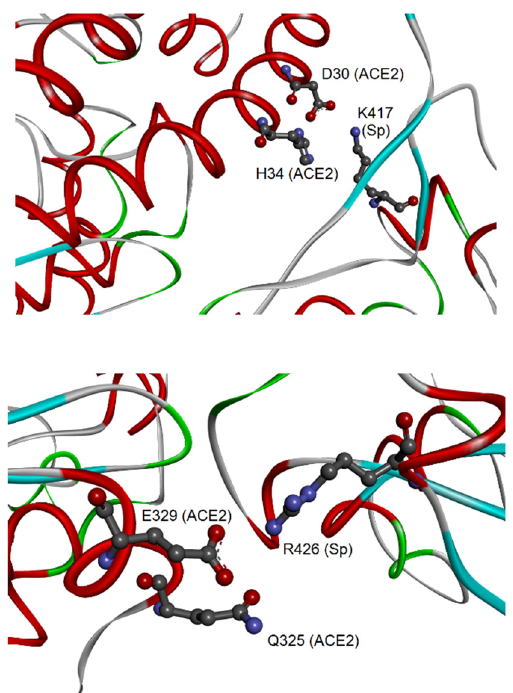
Figure 3. Molecular view of the peculiar interactions formed by CoV-2 K417 and CoV-1 R426 residues of the spike (adapted from Giordano et al., 2021 [37]). The upper panel shows the interaction of CoV-2 spike–K417 with ACE2-D30 and H34; both proteins are represented as backbone ribbons, with helix regions in red, beta-strand regions in cyan, and turns in green. The lower panel shows the interaction of CoV-1 spike–R426 with ACE2-Q325 and E329, with proteins drawn similarly to the upper panel.